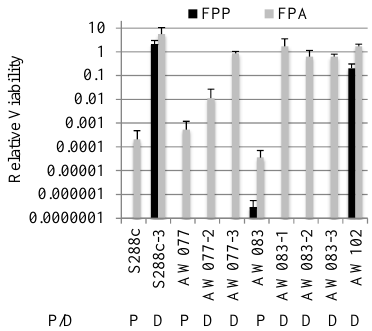
Figure 5. Viability of selected strains in response to FPP or FPA. Cultures of parental and derivative yeast strains were serially diluted in water then plated onto medium containing either 500 mg L −1 of FPA, FPP. Plates were incubated for 2–3 days and colony forming units (CFUs) counted. Relative viability was obtained by dividing the number of CFUs from drug plates by CFUs from YPD plates. P indicates the parental strain while D indicates a derivative of that strain. The average and standard deviation of three independent trials is shown.